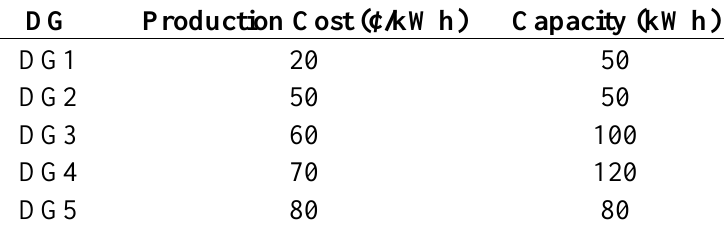
Table 7. DG information of Cases